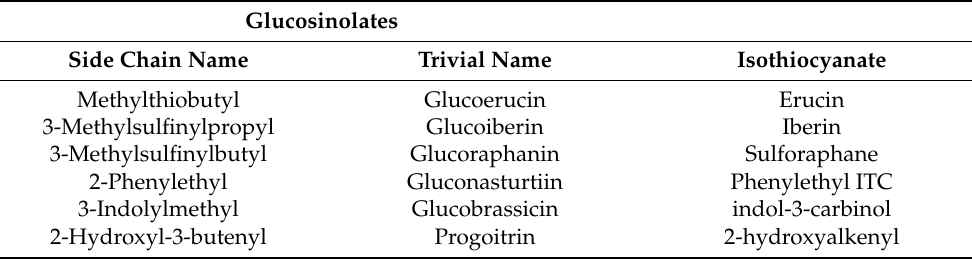
Table 1. Predominant glucosinolates in kale and their related isothiocyanates (ITCs). Glucosinolates Side Chain Name Trivial Name Isothiocyanate